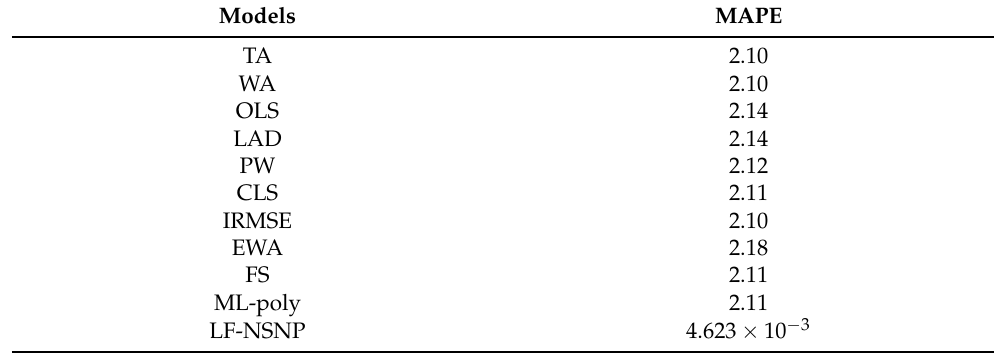
Table 2. MAPE metric value under the exploited LF-NSNP model and ten baseline models for case study